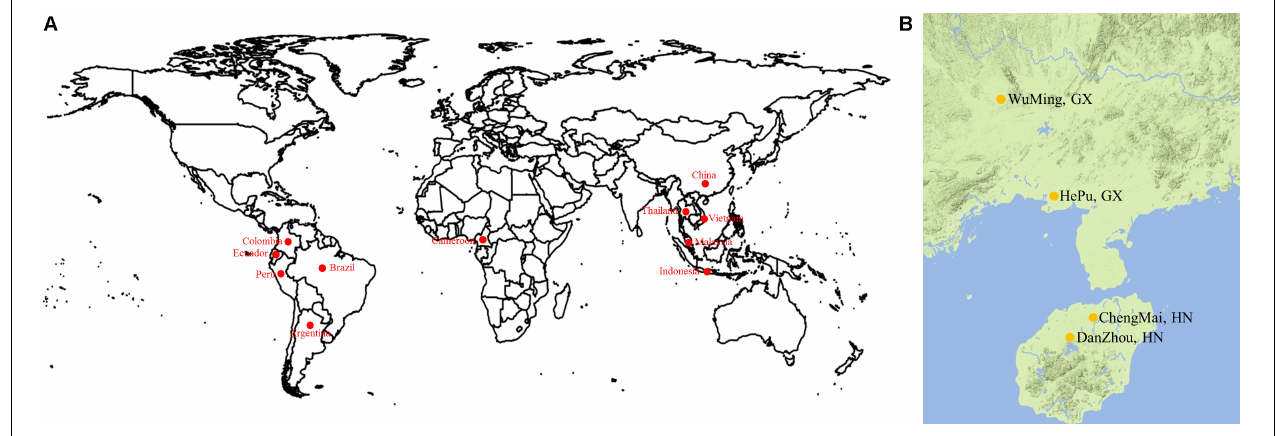
FIGURE 1 | (A) Geographical distribution of varieties. (B) Cassava accessions were grown with three replications in four experimental